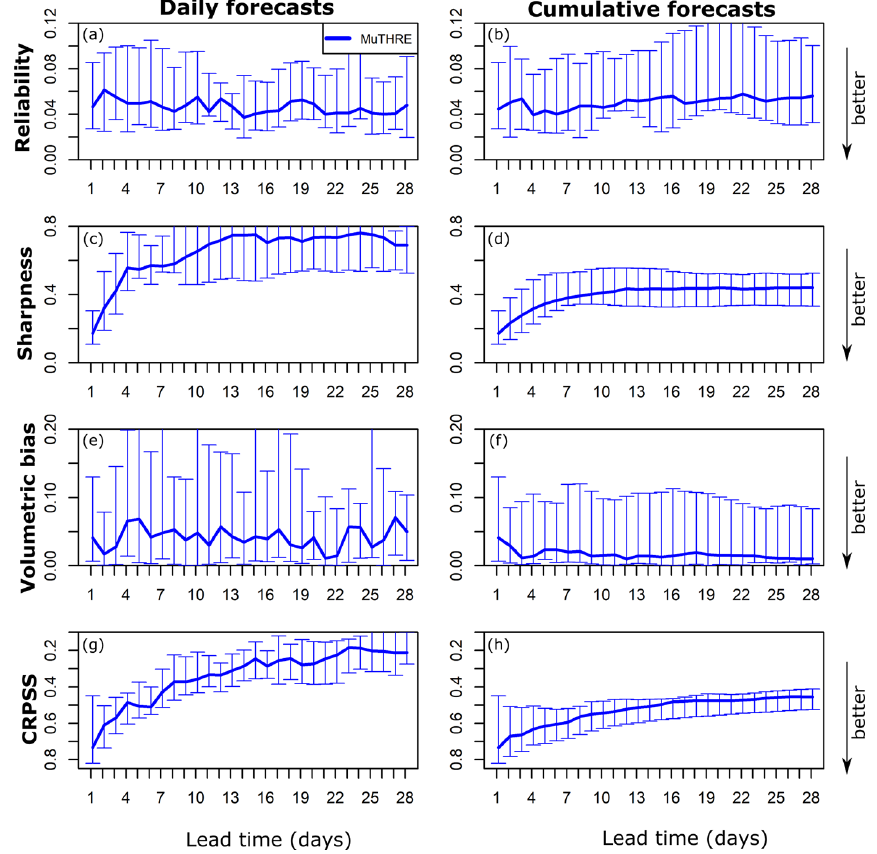
Figure 5. Performance of MuTHRE forecasts in terms of daily streamflow (a, c, e, g) and cumulative flow (b, d, f, h) . Metrics are shown for reliability (a, b) , sharpness (c, d) , volumetric bias (e, f) , and CRPSS (g, h) . The bars indicate the full range of metric values across the 11 case study catchments, and the line indicates the median metric values. Note the inverted y axis, for CRPSS, for visual consistency with the other